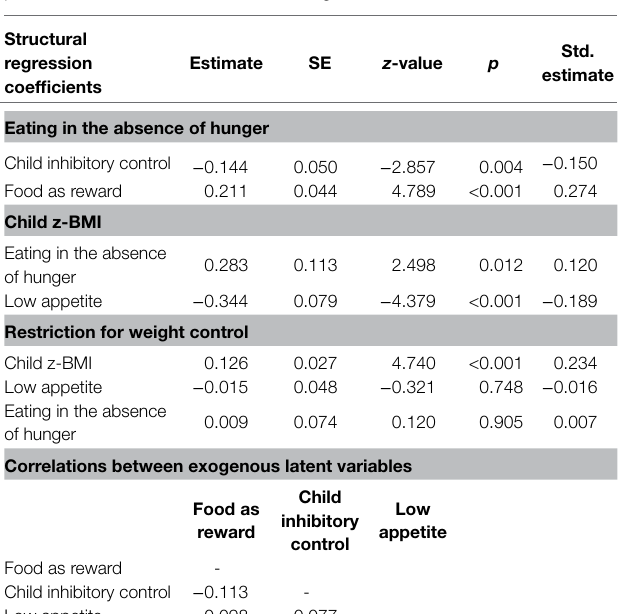
TABLE 4 | SEM model 1A: parameter estimates, SE, z -values, value of p , and standardized estimates (i.e., completely standardized solutions) for regression parameters, and correlations between exogenous latent variables.